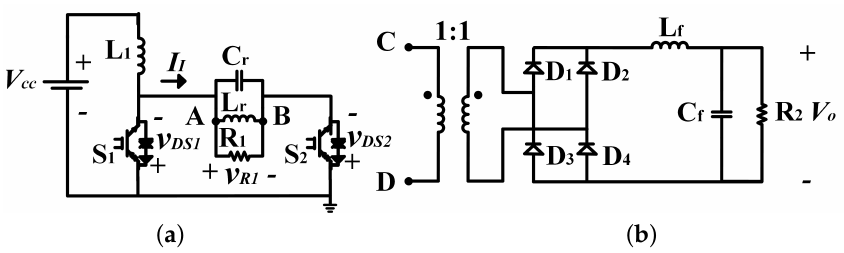
Figure 8. Resonant converter. ( a ) CSPRC, ( b ) adding transformer and